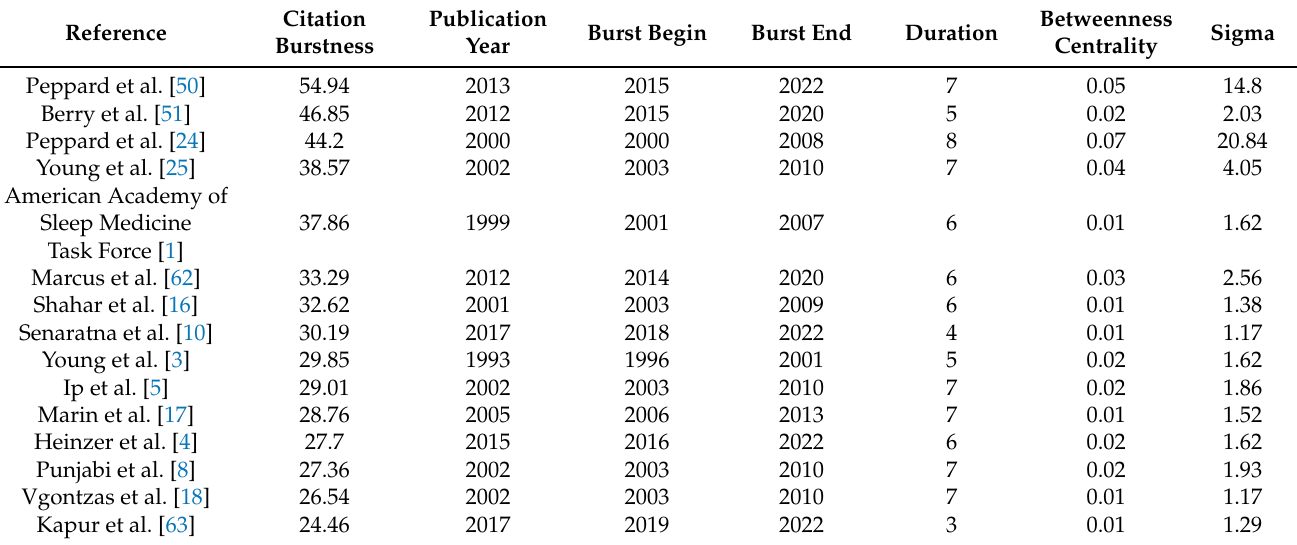
Table 2. Top 15 publications in terms of burst